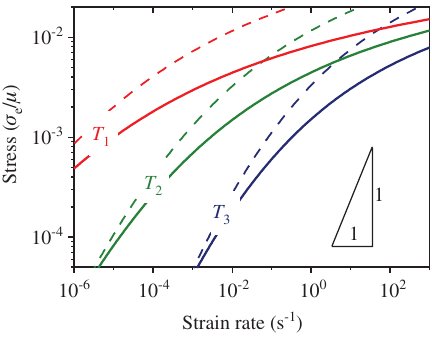
Figure 7 Dependence of the strain rate on external stress at several = 0.8 × T = T = 1.2 × T temperatures: T , T , and T . 1 g 2 g 3 g = 0.012 μ The temperature T was estimated as T v / k g g 0 a B [27]. The parameter of local activation volume v was a taken to be about 4.5 v [28]. As was expected, the curves a s for different temperatures meet at same stress point σ 0 where the sliding time tends to zero. This point has a simple physical meaning, namely, the threshold of ather- mal planar sliding at T → 0. The deformation map shown MG [29].